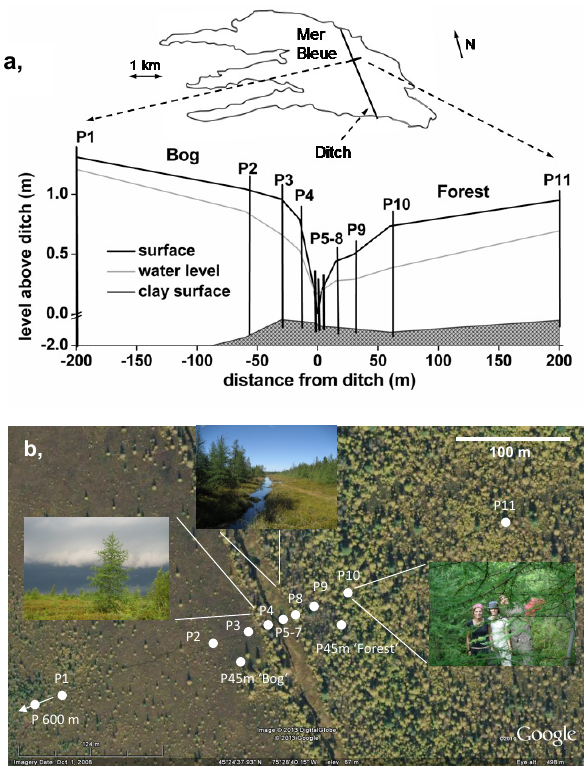
Fig. 1. Cross section of the study transect installed perpendicular to the drainage ditch in the western part of the Mer Bleue Bog, On- tario, Canada ( a ), and Google Earth image of the site during the simulation period in September, 2008 ( b ). (a) illustrates the posi- tion of the peat surface, piezometer nest arrangement (P1–P11), the water level and the peat–clay interface. Additional piezometer nests, serving as reference sites, were installed 600m from the ditch in the open bog and 45m from the ditch on both sides. Peat depth is verti- cally exaggerated. (b) illustrates the distinct differences in terms of vegetation between both sides of the transect. The 60m Forest site supported on average 4900gm − 2 aboveground biomass, whereas the 200m Bog site only supported 690gm − 2 (Talbot,